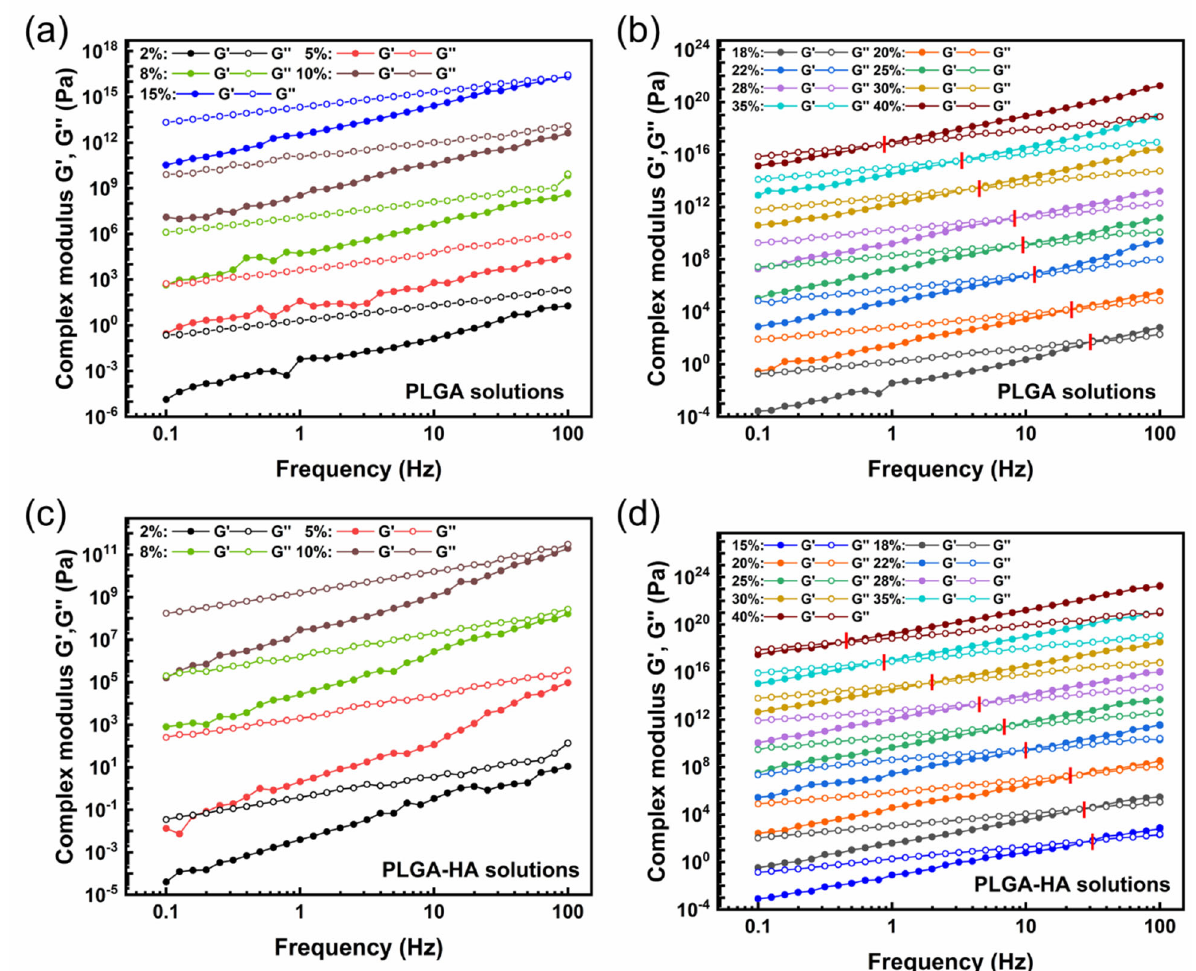
Figure 4. Crossover of complex moduli for different PLGA concentrations of pure PLGA solutions ( a , b ) and PLGA-1.5% HA solutions ( c , d ). ( a , c ) showed no crossover point for G ′ and G ″ in unentan ‐ gled regimes for both solutions; however, ( b , d ) showed the corresponding crossover frequency for G ′ and G ″ as marked by the red lines. The curves were shifted with y ‐ displacement to visually show the crossover point. Curves of complex modulus without shifting are presented in Supporting Information Figure S1. The Cox–Merz rule was validated and is shown in supporting information Figure S2.